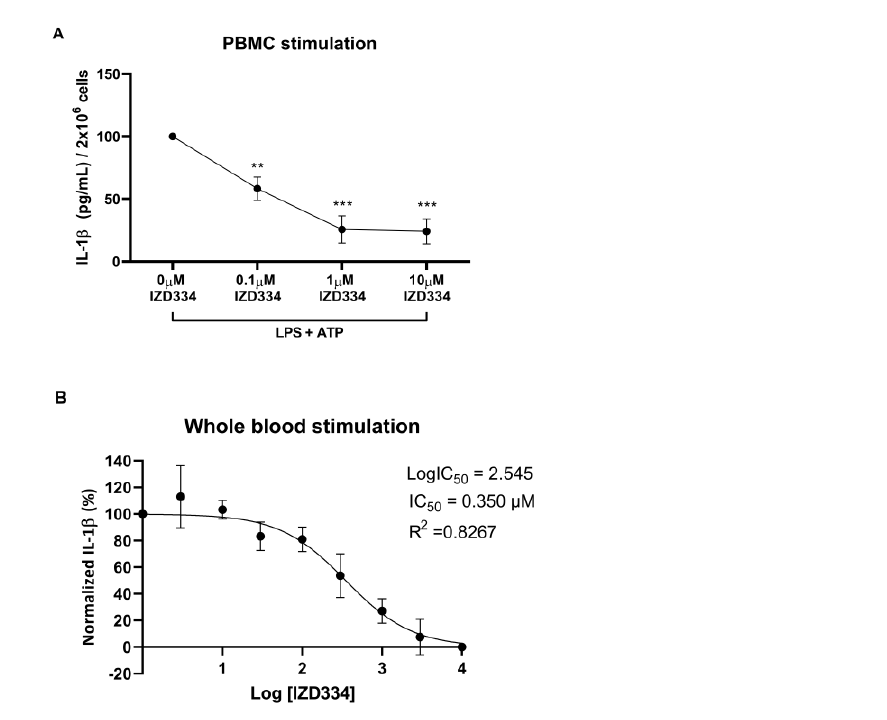
Figure 1. In vitro reduction of IL-1 β secretion. ( A ) Porcine peripheral blood mononuclear cells (PBMCs) released IL-1 β after administration of lipopolysaccharide (LPS) and adenosine triphosphate (ATP) in vitro. Addition of IZD334 reduced IL-1 β release ( n = 3). ( B ) Whole blood IC50 calculation after stimulation with LPS and ATP and administration of increasing concentrations of IZD334 in vitro. p -values (** <0.005, *** <0.0005) are compared to vehicle control (0 µ M of IZD334).